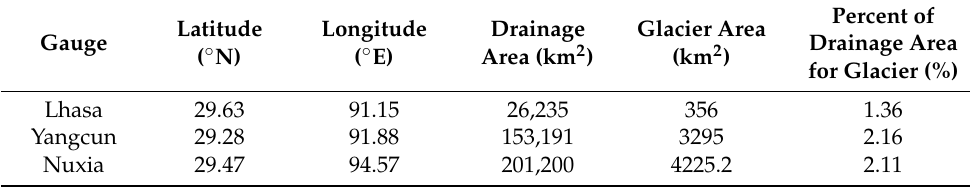
Table 1. Basic information of the three flow gauges in the Upper Brahmaputra River Basin.